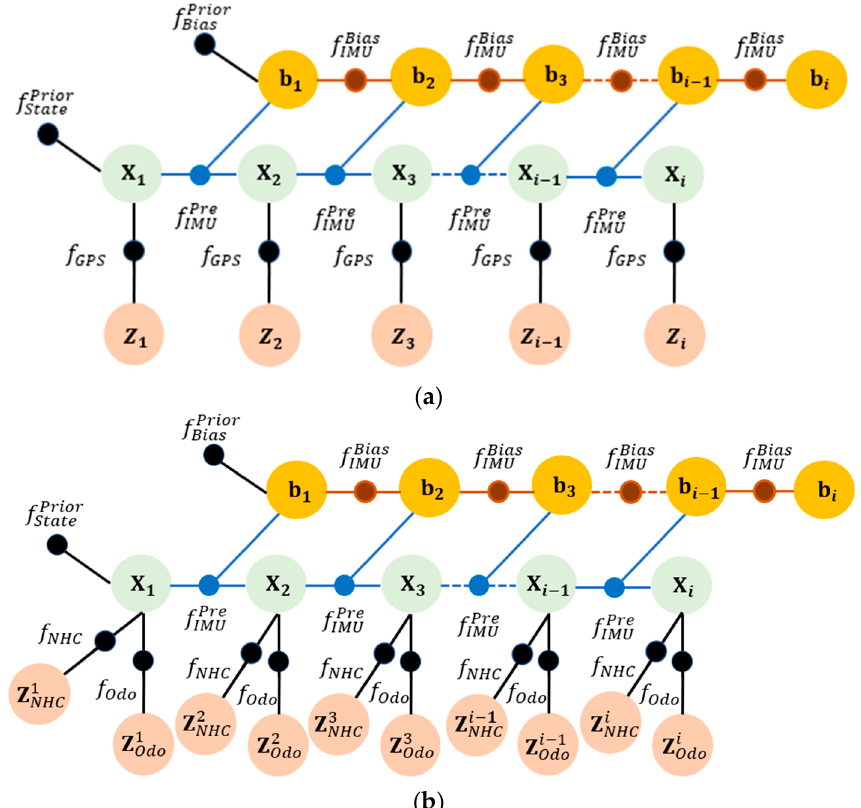
Figure 2. FGO GNSS/INS/NHC/Odometer integration. ( a ) FGO-GNSS/INS. ( b ) FGO-IMU/Odome- ter/NHC.